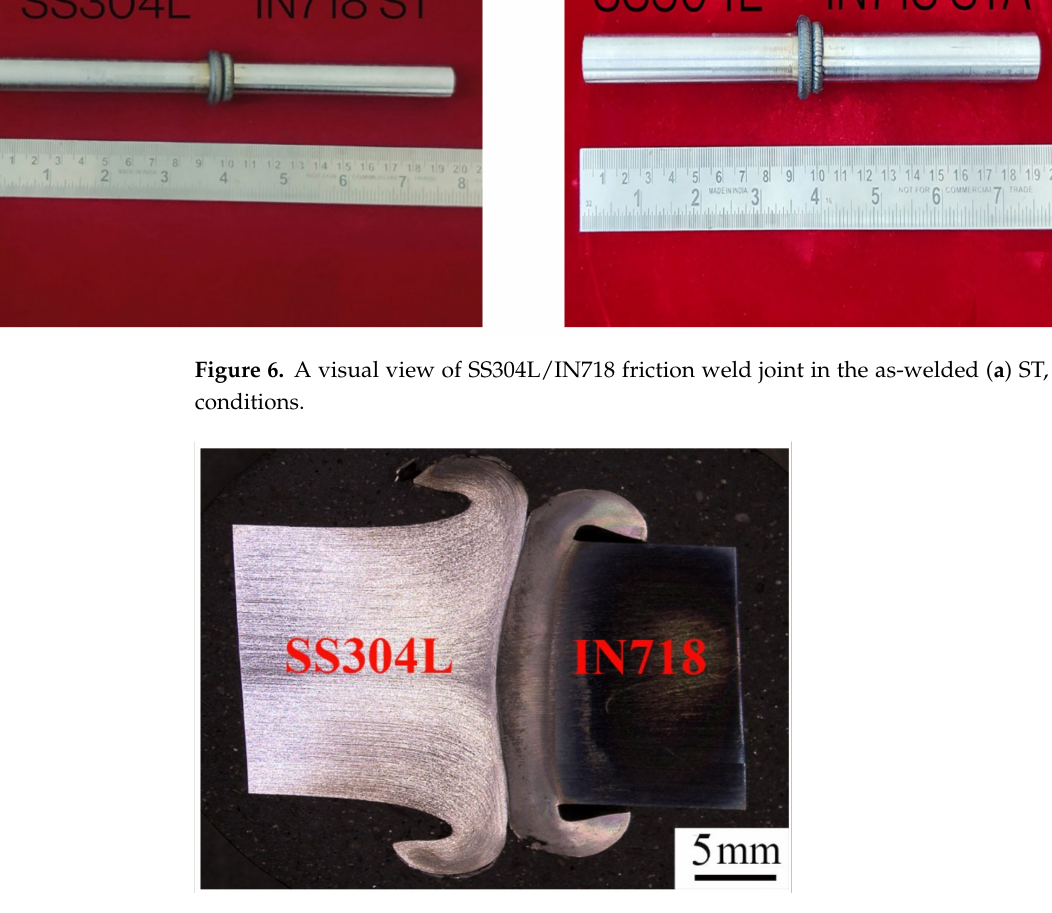
Figure 7. The macrostructure of the dissimilar rotary friction welded SS304L/IN718 ST sample shows more flash on the SS304L